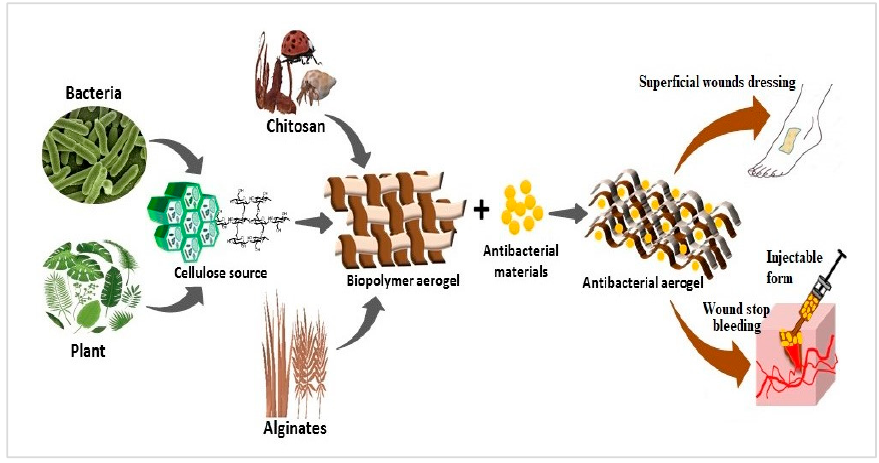
Figure 5. Schematic drawing of biopolymer aerogels for wound healing [100].